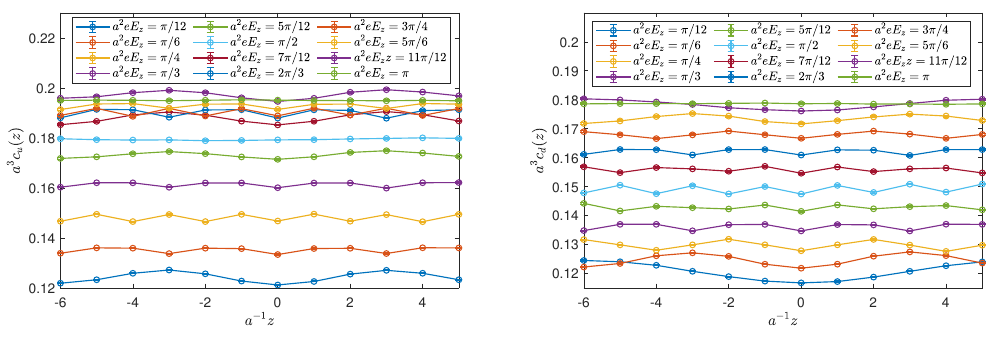
Figure 4 . Same as figure 3 but for β = 5 . 64 .